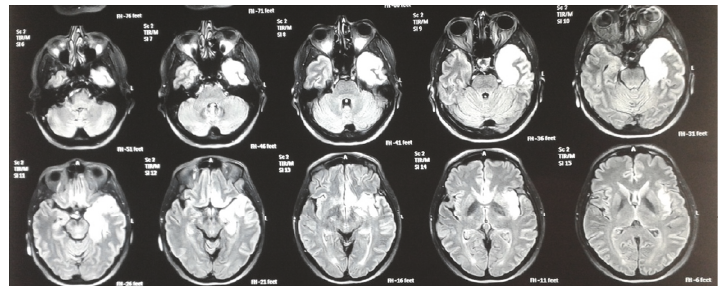
Figure 3: MRI brain scan. Notice the hyperintense depiction of the left temporal and the frontal lobe and the island of Reil in T2WI and FLAIR